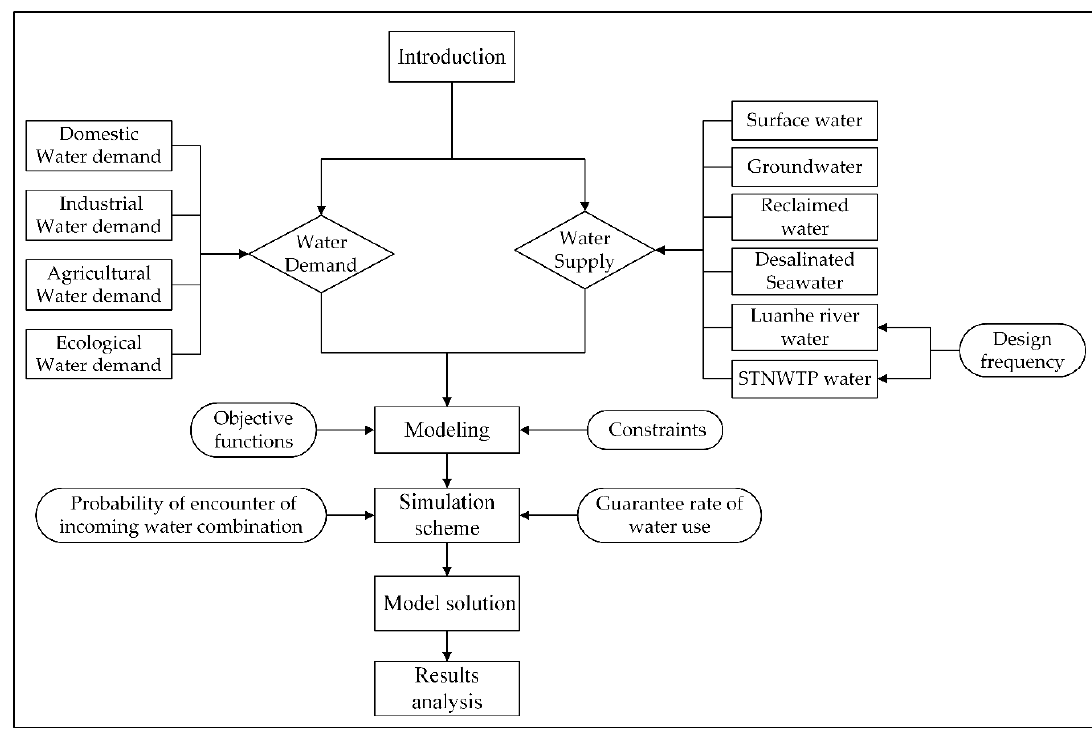
Figure 2. The flow chart of the research.